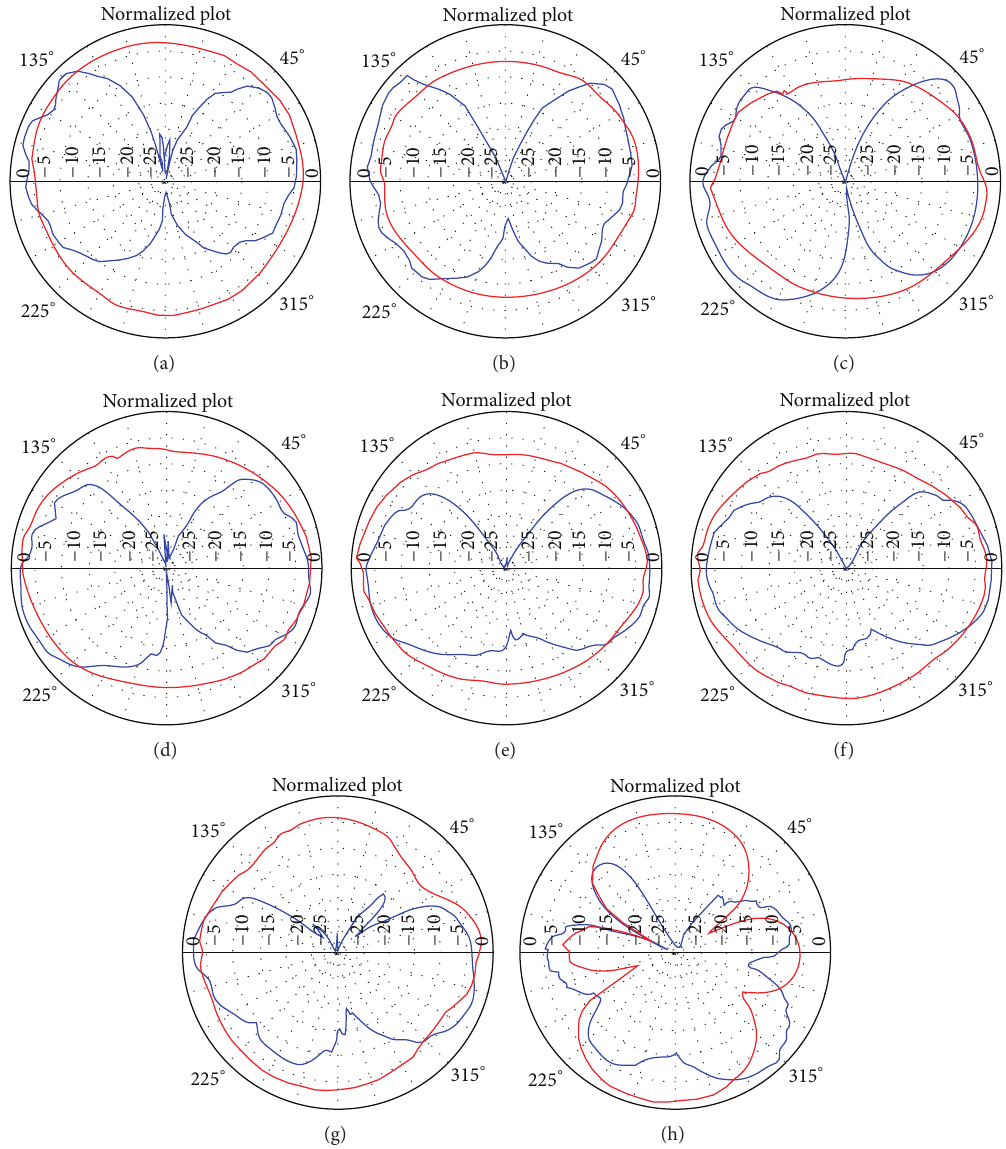
Figure 8: Normalized measured radiation patterns of the antenna at (a) 3GHz, (b) 4.5GHz, (c) 6 GHz, (d) 7.5GHz, (e) 9GHz, (f) 10.5GHz, (g) 12GHz, and (h)